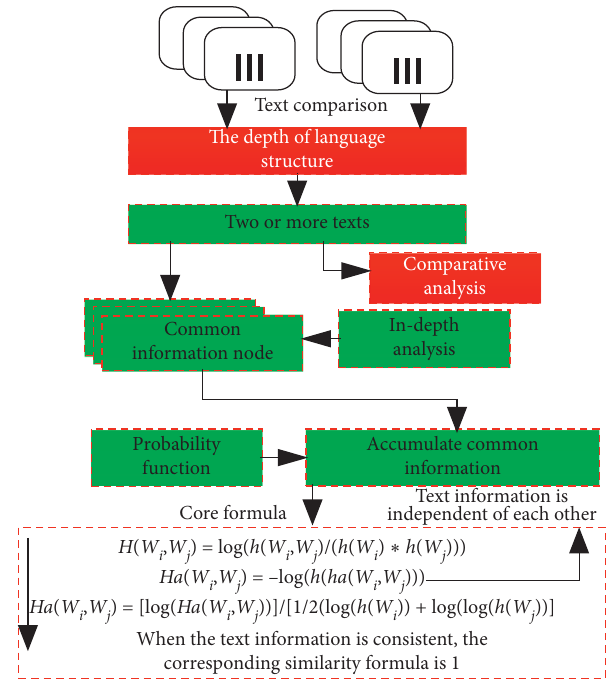
Figure 3: Calculation flow chart of the language structure depth analysis